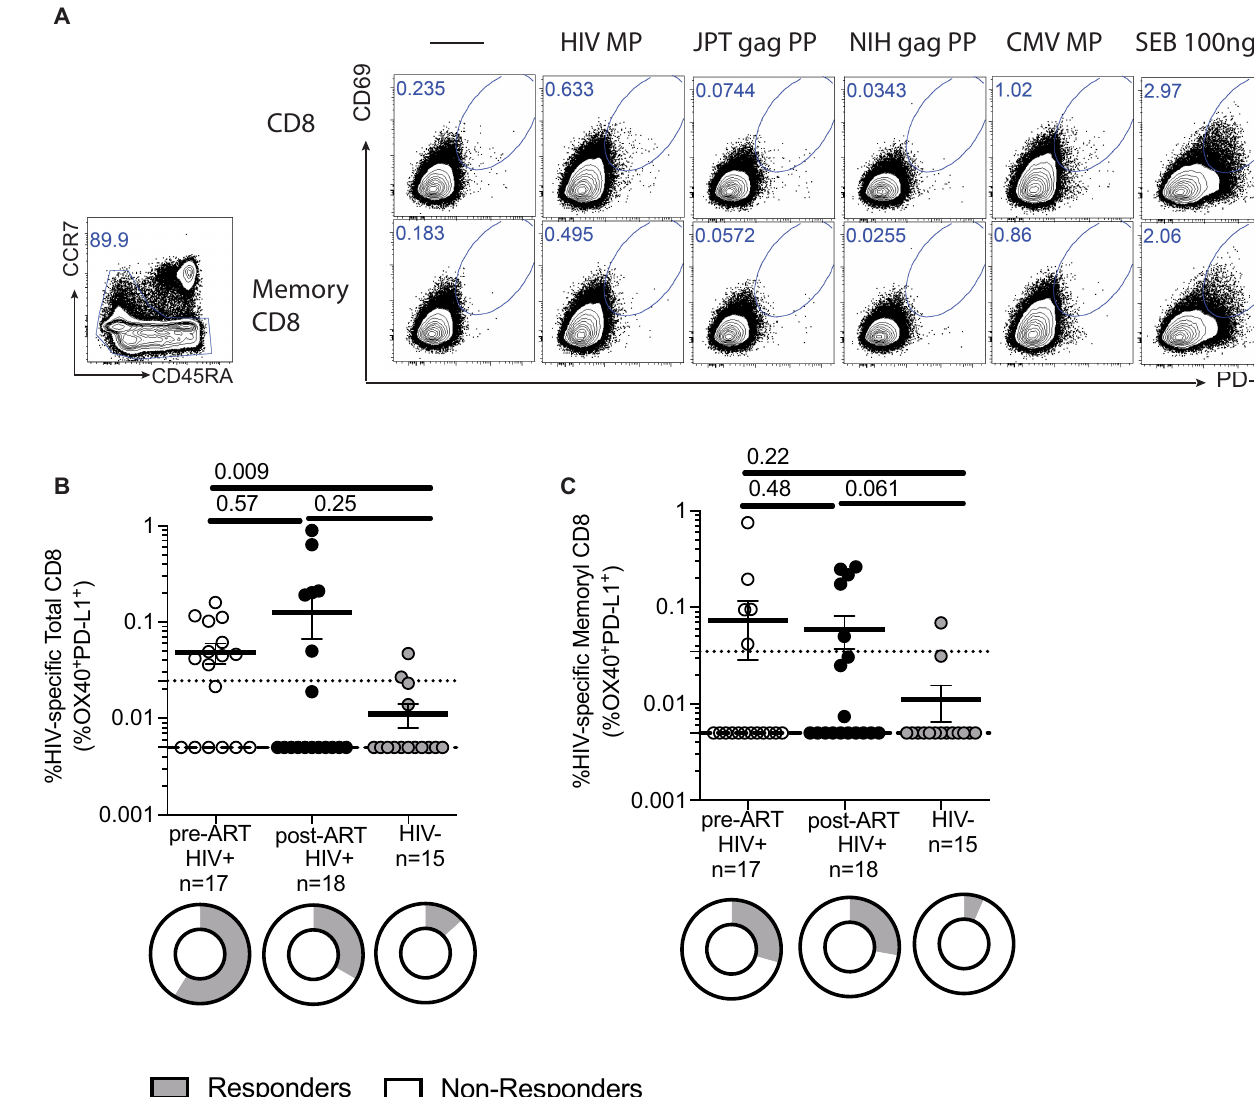
Fig 2. Detection of HIV-specific CD8 + T cells. (A) Sample flow cytometry plot showing gating strategy for HIV-specific CD8 + T cells based on co-expression of CD69 and PD-L1 on total CD8 and memory CD8 T cells. Specimens from HIV infected donors have a higher frequency of (B) HIV-specific total CD8 + T cells and (C) HIV-specific memory CD8 + T cells compared to HIV negative specimens. There was no statistical difference between pre-ART and post-ART specimens. Data was background subtracted. P-values by Mann-U Whitney test. Limit of detection (dashed line) was set at 0.005%. Limit of sensitivity (dotted line) was 0.025% for HIV-specific total CD8 + T cells and 0.035% for HIV-specific memory CD8 + T cells. Data presented represents mean ± standard error of the